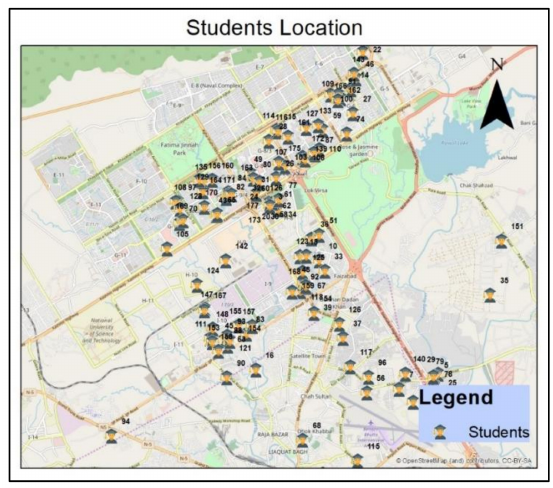
Figure 3. Student locations